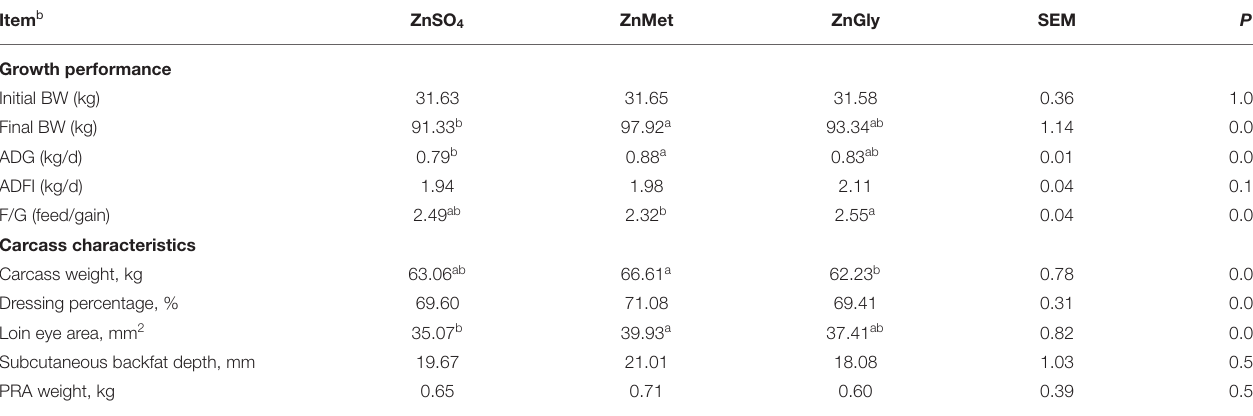
TABLE 3 | Growth performance and carcass characteristics of finishing pigs fed Zn diets a .